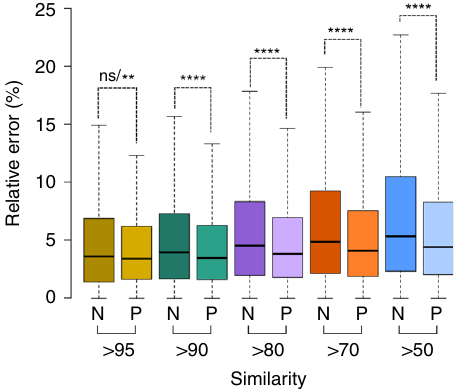
Fig. 2 Naïve k -NN approach and DLM approach comparison. Box plots for the naïve k -NN (N) and DLM (P) relative RT prediction error across similarity thresholds are shown. P values from paired Wilcoxon rank tests are summarized with asterisks ( n 95 = 648, n 90 = 6018, n 80 = 14028, n 70 = 16974, n 50 = 19817) except for the 95 % threshold, for which ns (not signi fi cant) corresponds to the Wilcoxon rank test whereas the asterisks correspond to the Ansari – Bradley P value. Box plots represent median value and interquartile range (25 – 75 % percentiles) excluding outliers.